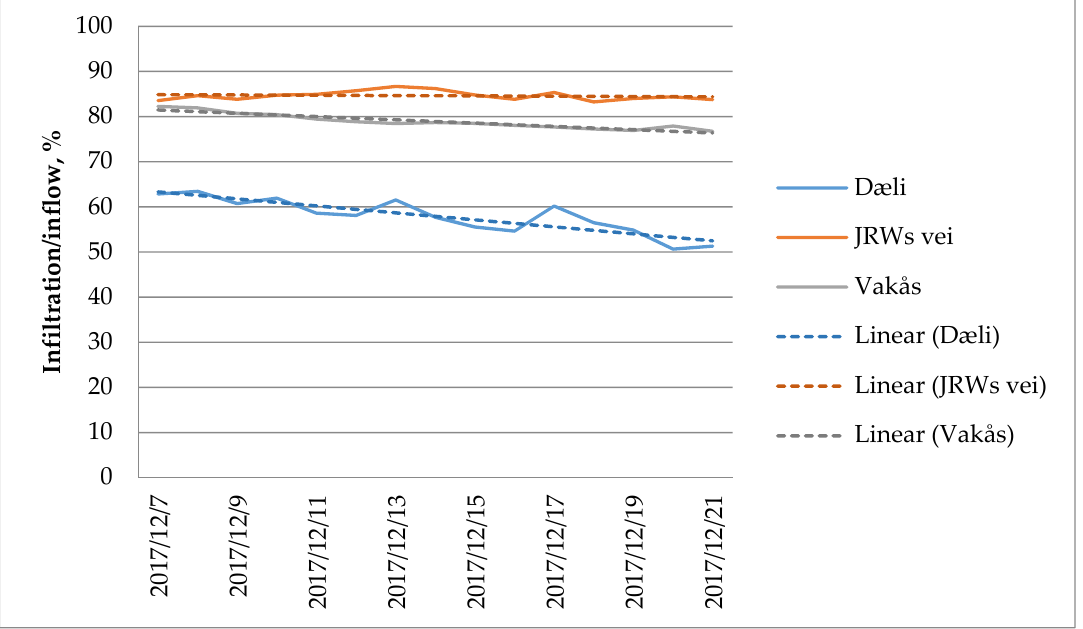
Figure 6. Calculated share of I/I-water during a dry weather period, after the implementation of the measures. In this period, JRWs vei was the area with the highest share of I/I-water, between 82% and 87%, which is an increase from the assessed period in 2016. In the Vakås area, the share varied between 77% and 82%, whereas the share in Dæli varied between an estimated 51% and 63%. Despite increased shares of I/I-water in the control area when comparing shares of I/I-water before and after the implementation of the measures, we registered a